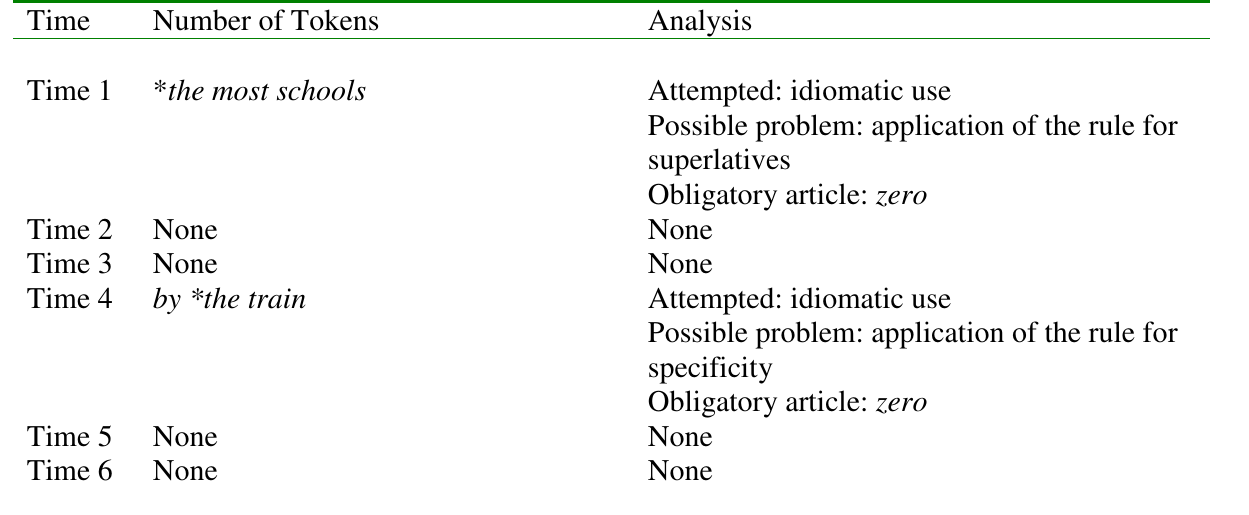
Overuse and Misuse of the by Time Analysis